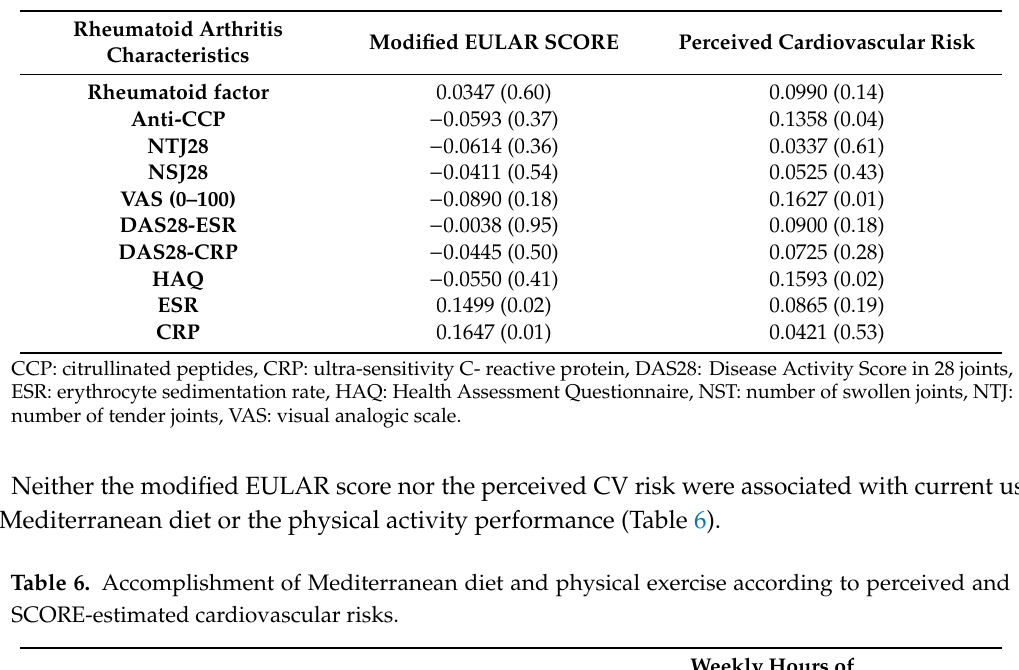
Table 5. Spearman correlation between rheumatoid arthritis characteristics and SCORE-EULAR 2016 and cardiovascular risk perception.